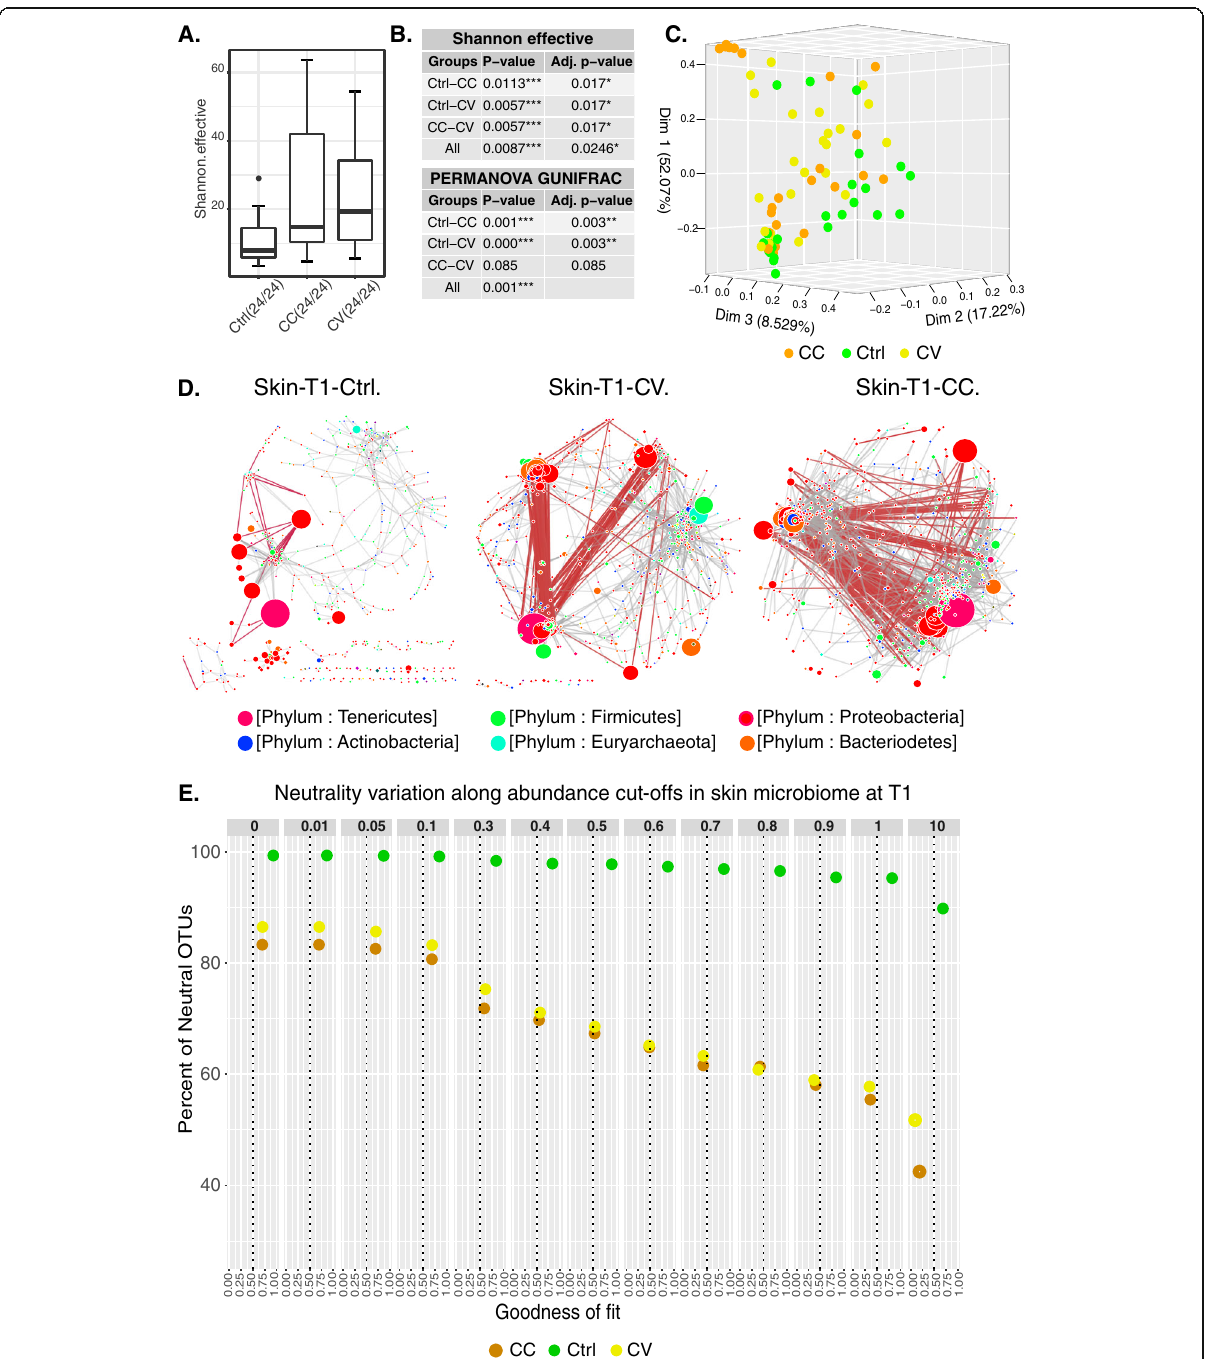
Fig. 1 Diversity, structure, and assembly of the skin microbiome. a highlights the negative correlations in the co-abundance networks of skin microbial community. Each node size in the network is proportional to the average of the OTUs relative abundance in all samples. These networks are based on significant Spearman coefficients and were constructed using R scripts and Cytoscape software. b shows the boxplots of the significant difference in alpha-diversity (Shannon effective). c summarises the statistical tests of alpha-diversity and beta-diversity (Gunifrac distance). d represents the PCOA 3D plot of the microbial skin communities of all treatment groups based on the significant difference of generalized Unifrac distances tested with PERMANOVA, MRPP and multiple correction test (See Supplementary Table 3) e reports the distribution of neutrality versus abundance cut-off and goodness of fit. The plot shows the variation of neutral OTUs percentage (Y-axis) along with the goodness of fit predicted by NLS models using 12 cut-offs of relative abundance averages (facet panels) in the skin metacommunity at T1 and